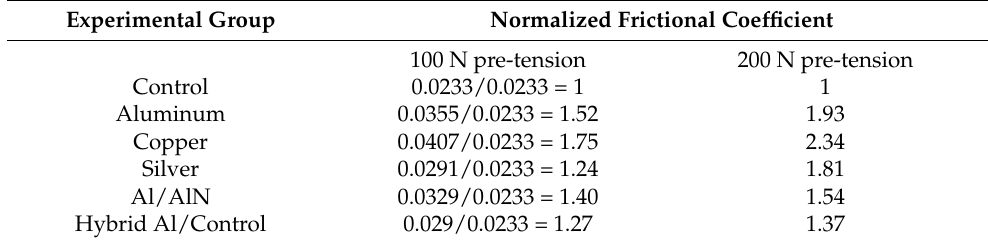
Table 3. Normalized friction coefficients at 100 N and 200 N transverse pre-tension.